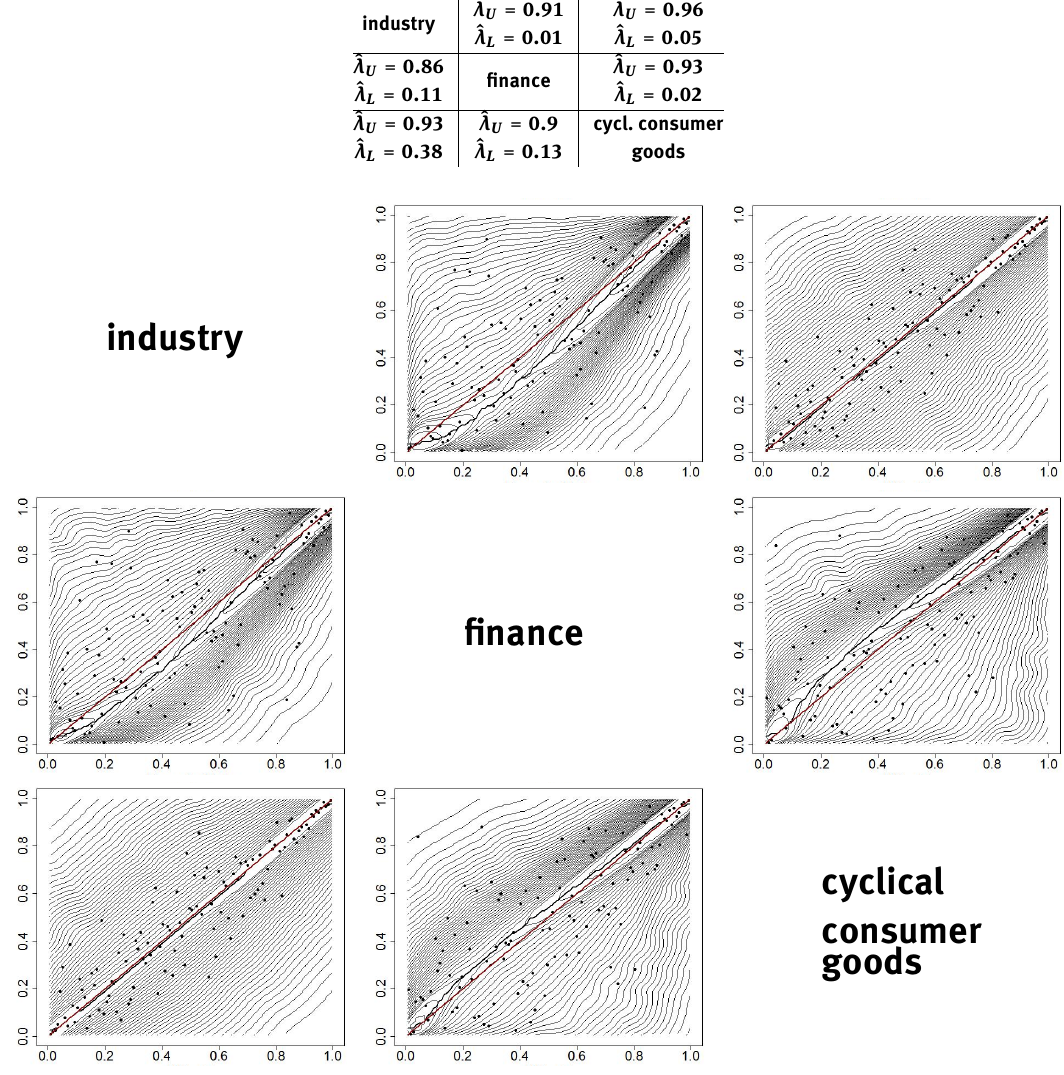
Fig. 7. Estimated bivariate copulas of the CBV (upper triangle matrix) and the MCG model (lower triangle matrix) together with empirical